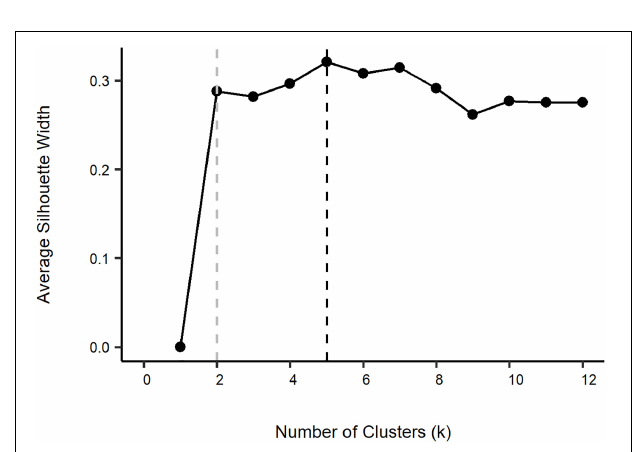
FIGURE 5 | Average silhouette width from Q-mode k- mediods cluster analysis using the proportions matrix with “units” (year-month-subarea-gear). The suggested optimal number of clusters is k = 5 (black dashed line), but the average silhouette width plateaus at k = 2 (gray dashed